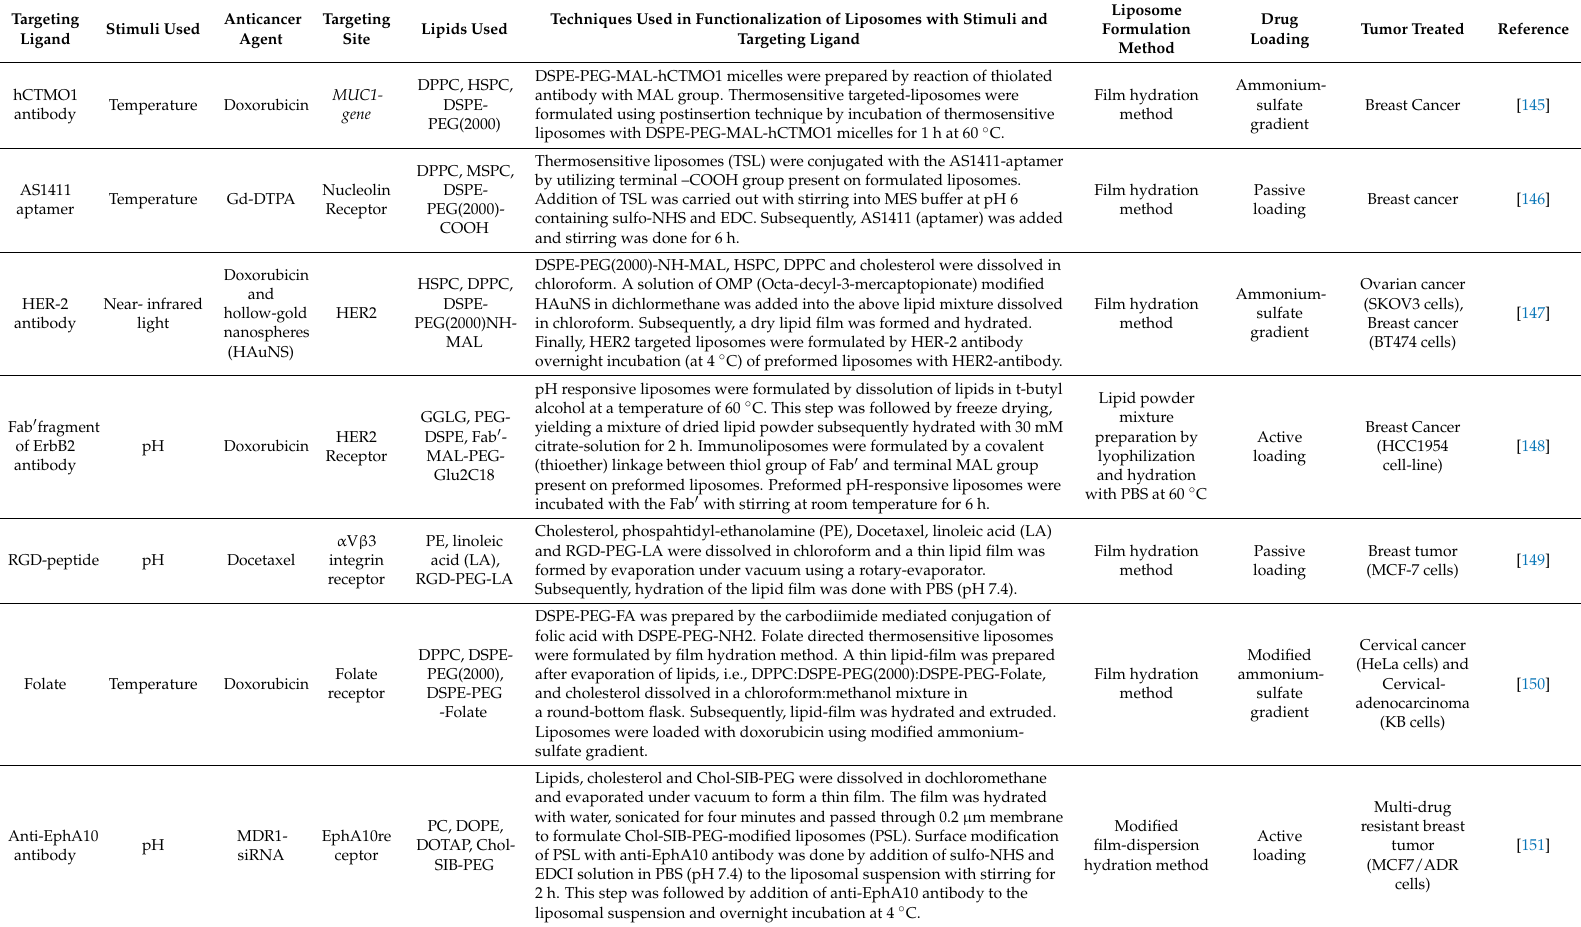
Table 3. Dual functionalized liposomes responsive to stimuli and grafted with targeting